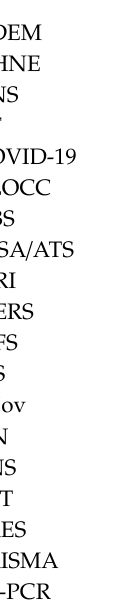
Table S1: Complete reference list of included studies in the